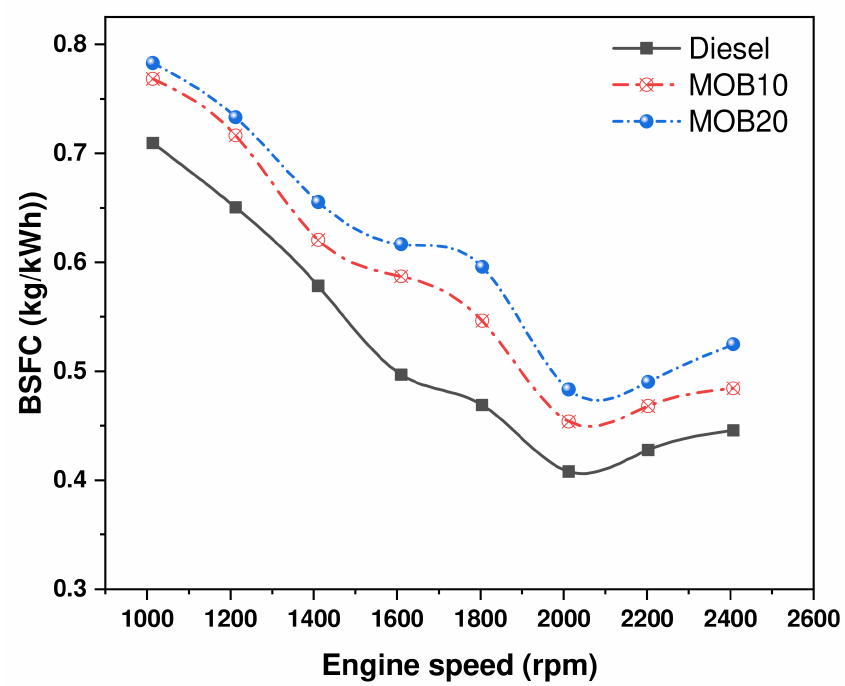
Figure 3. Variation in BSFC with varying engine speed for biodiesel blends and